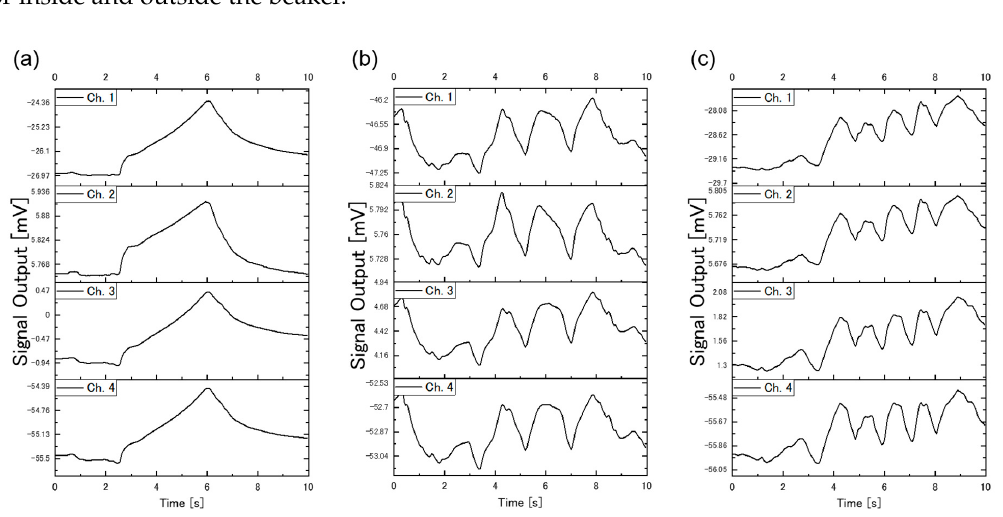
Figure 4. Examples of sensing signals for each protocol; the measurement device was brought into the headspace of the beaker ( a ) once (Protocol-1), ( b ) 3 times (Protocol-3), and ( c ) 5 times (Protocol-5). Water was used as a sample.